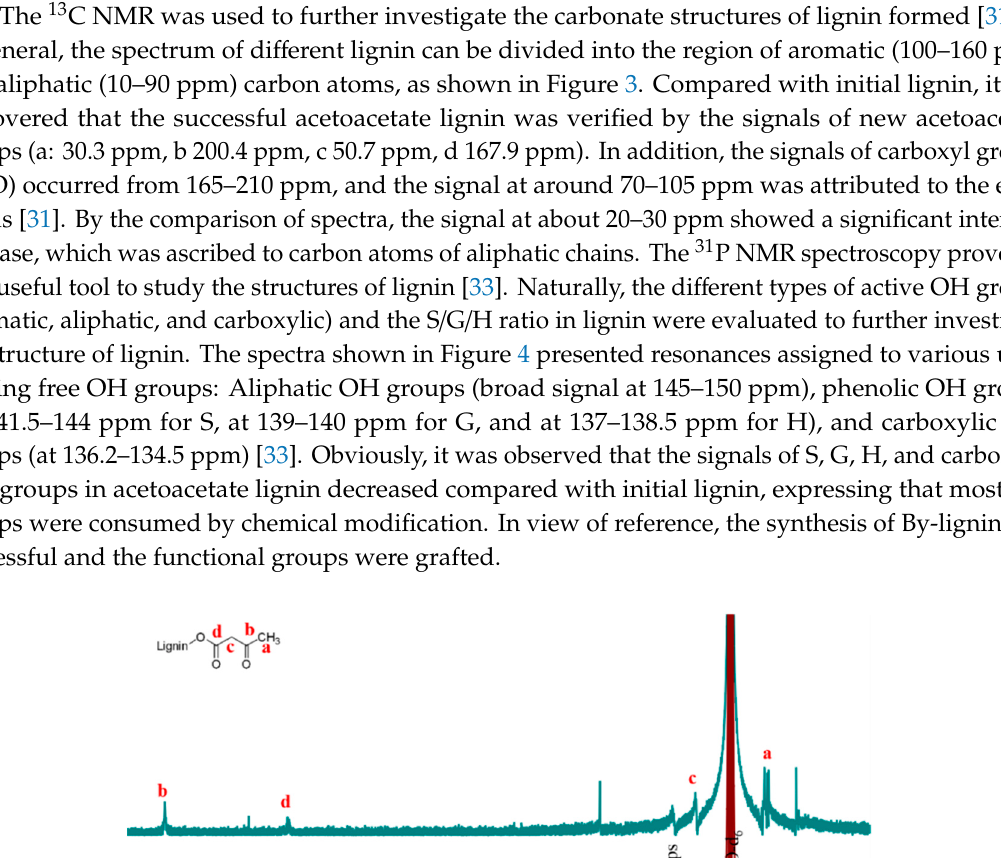
Figure 2. The 1 H NMR spectra of ( a ) Ac-lignin and At-lignin; ( b ) Ac-lignin and By-lignin.